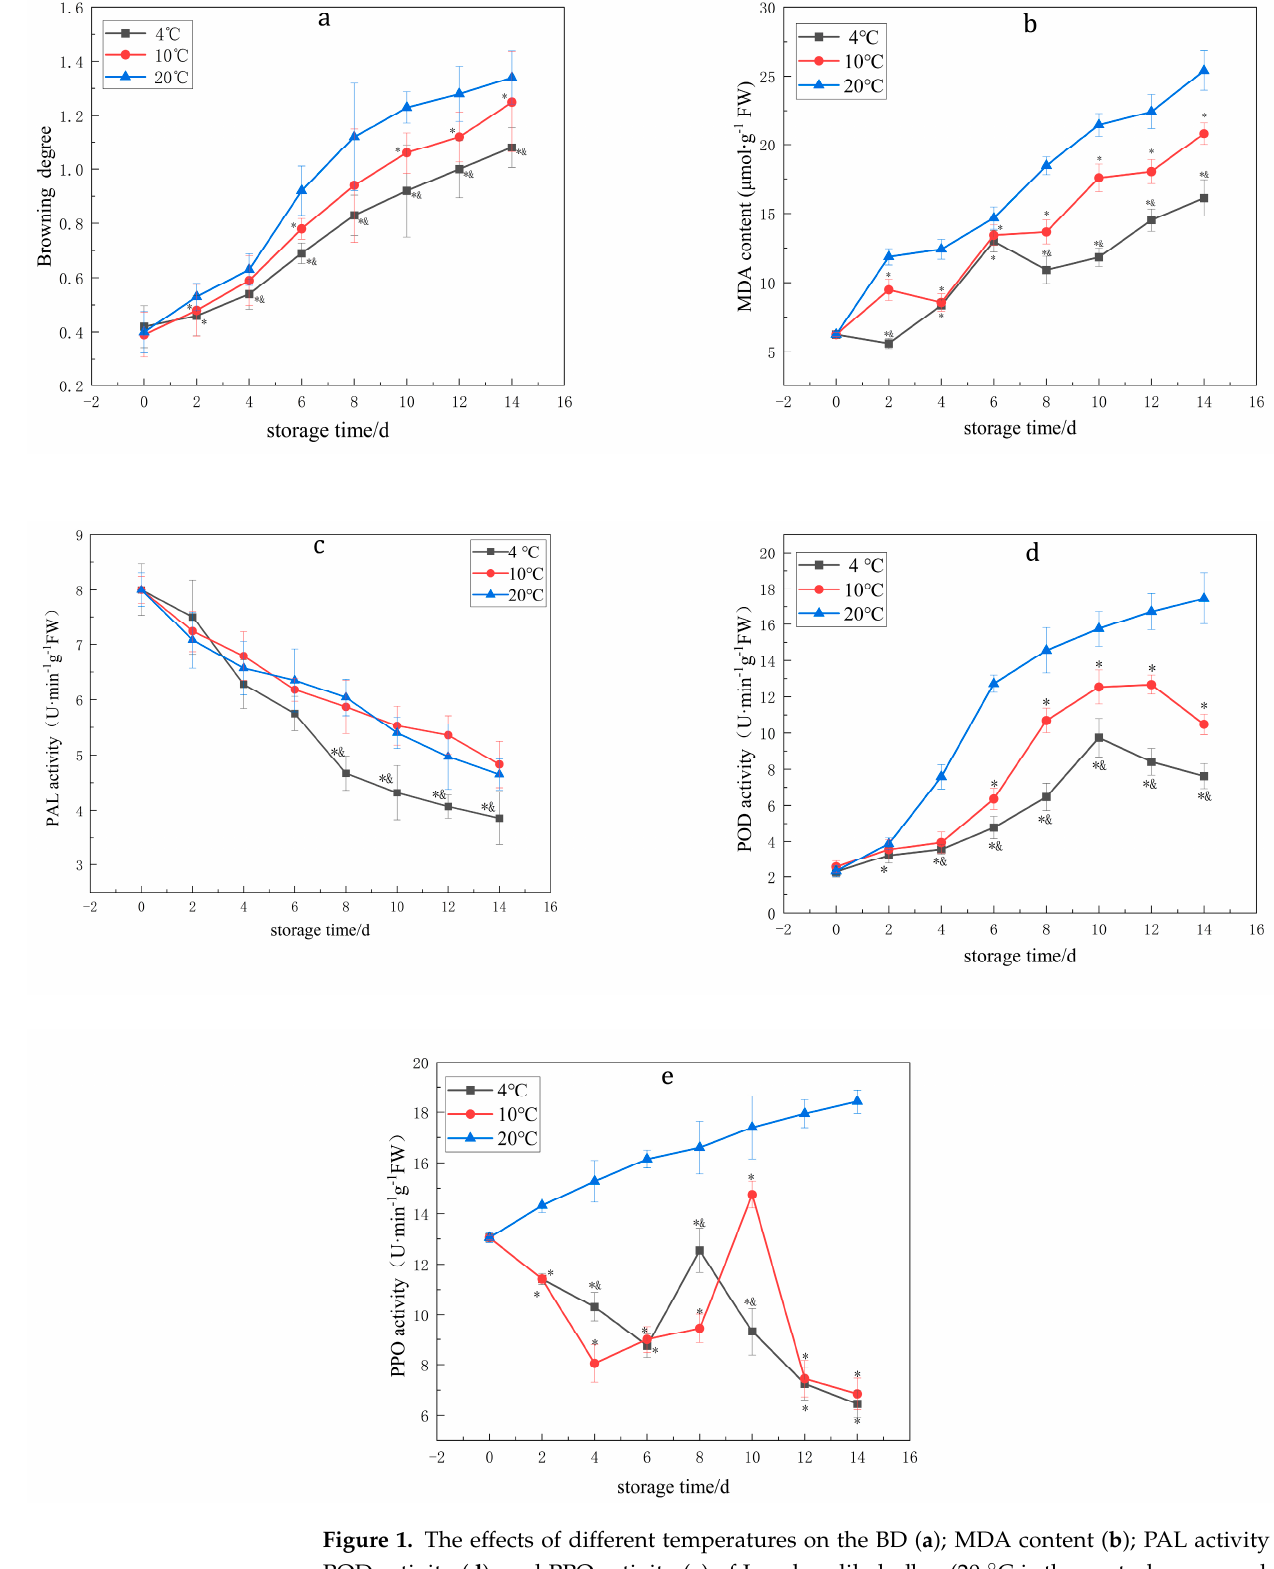
Figure 1. The effects of different temperatures on the BD ( a ); MDA content ( b ); PAL activity ( c ); Figure 1. The e ff ects of di ff erent temperatures on the BD ( a ); MDA content ( b ); PAL activity ( c ); POD POD activity ( d ); and PPO activity ( e ) of Lanzhou lily bulbs. (20 ◦ C is the control group and the activity ( d ); and PPO activity ( e ) of Lanzhou lily bulbs. (20 °C is the control group and the fresh- fresh-keeping groups are 4 ◦ C and 10 ◦ C. *, compared to 20 ◦ C, p < 0.05; &, compared to 10 ◦ C, keeping groups are 4 °C and 10 °C. *, compared to 20 °C, p < 0.05; &, compared to 10 °C, p < 0.05). p <